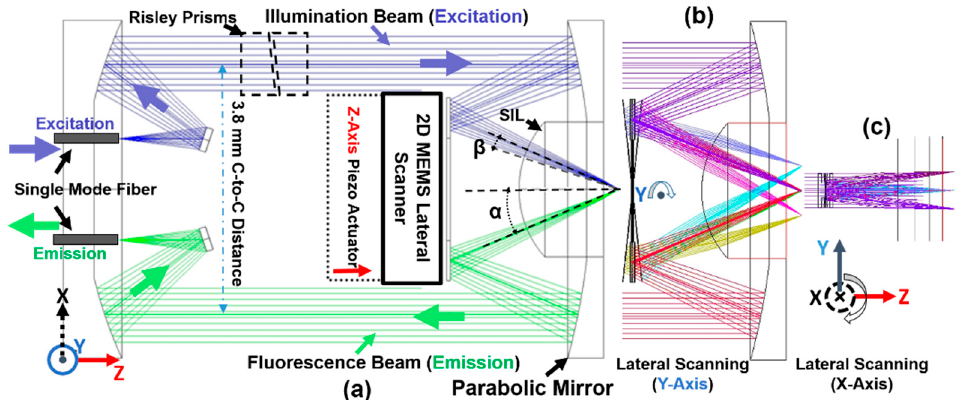
Figure 1. Ray-tracing simulation of the optical design for the MEMS-based intraoperative near-infrared (NIR) confocal microscope’s scan-head (outer diameter (OD): 5.5-mm package). ( a ) Schematic drawing of the scan-head, such as the collimating, focusing, and scanning in the post-objective dual-axis confocal architecture aimed for 3D NIR fluorescence imaging, demonstrating the geometric requirements for the MEMS scanner; a pair of tiny Risley prisms were used for precise alignment; single-mode fibers (S630HP, numerical aperture (NA) = 0.12) were used for delivering and collecting light beams; SIL: solid immersion lens, β : free-space numerical aperture of the individual beams, and α : the intersection half-angle of the beams. ( b ) Lateral scanning around the Y -axis of the micro-mirror. ( c ) Lateral scanning around the X -axis of the micro-mirror.